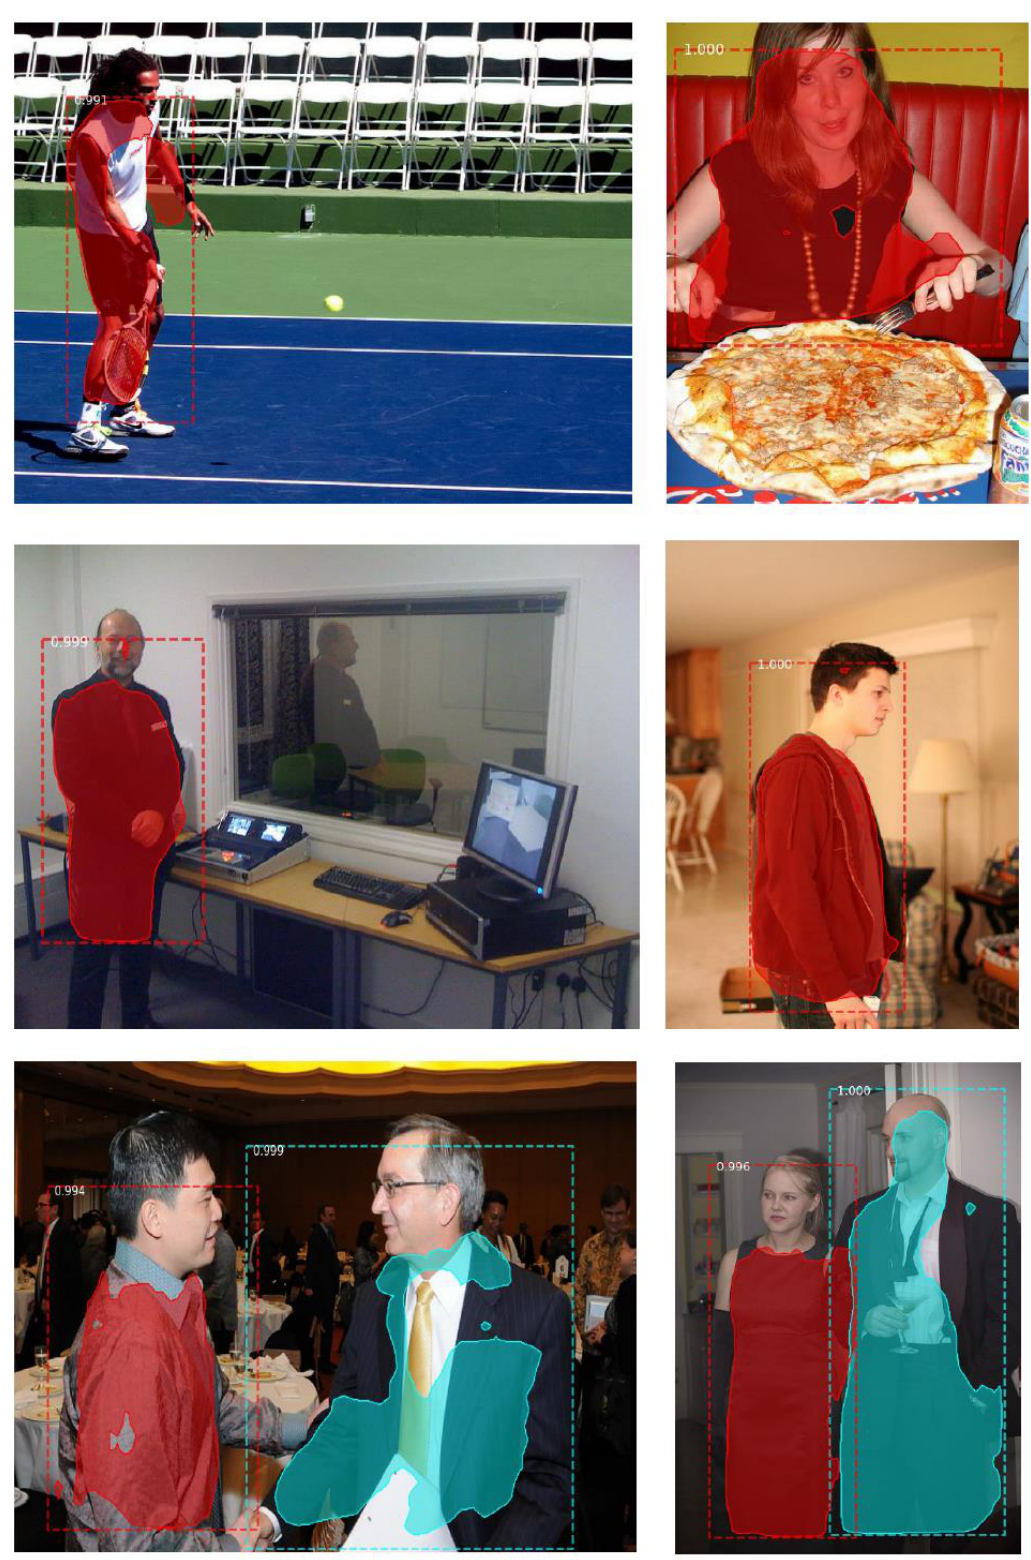
Figure 14. Results for 3 m_high_tack_spray_adhesive data using the Mask R-CNN-based object de- tection method. The column on the left contains the input images. The column on the right shows the positioning and segmentation results.